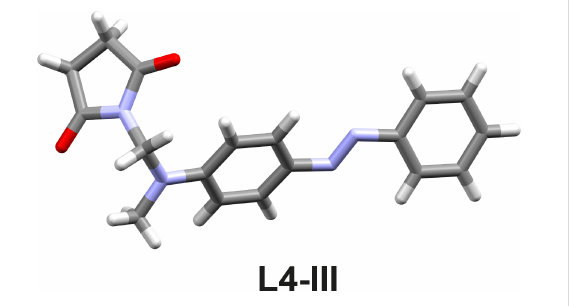
Figure 3: Experimental X-ray molecular structure of succinimide prod- uct L4-III .